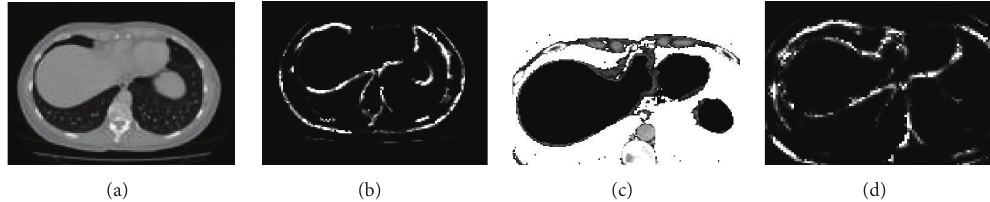
Figure 3: Edge-detection results. (a) Input: sample special slice. (b) Output of normal ACO. (c) Input: ROI-based image of (a). (d) Output of variant